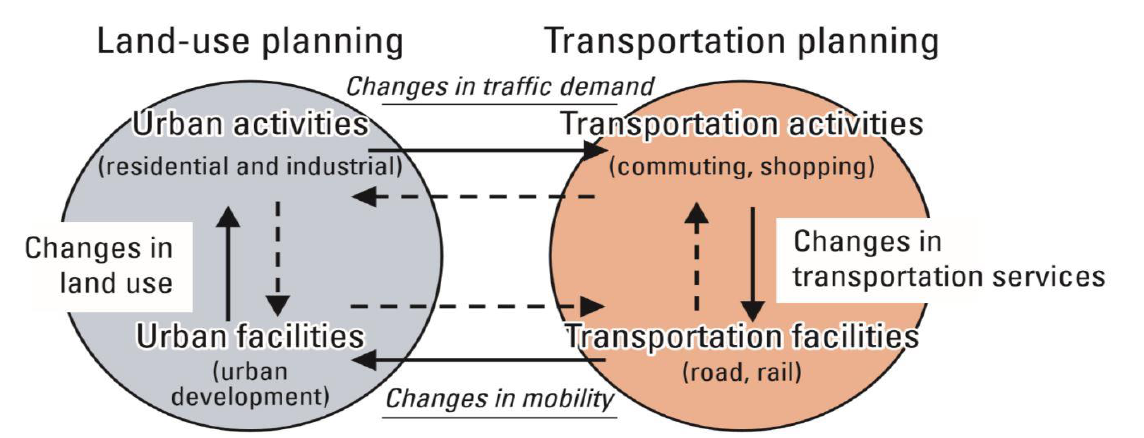
Fig. 2. The Relationship between Land Use Planning and Transportation